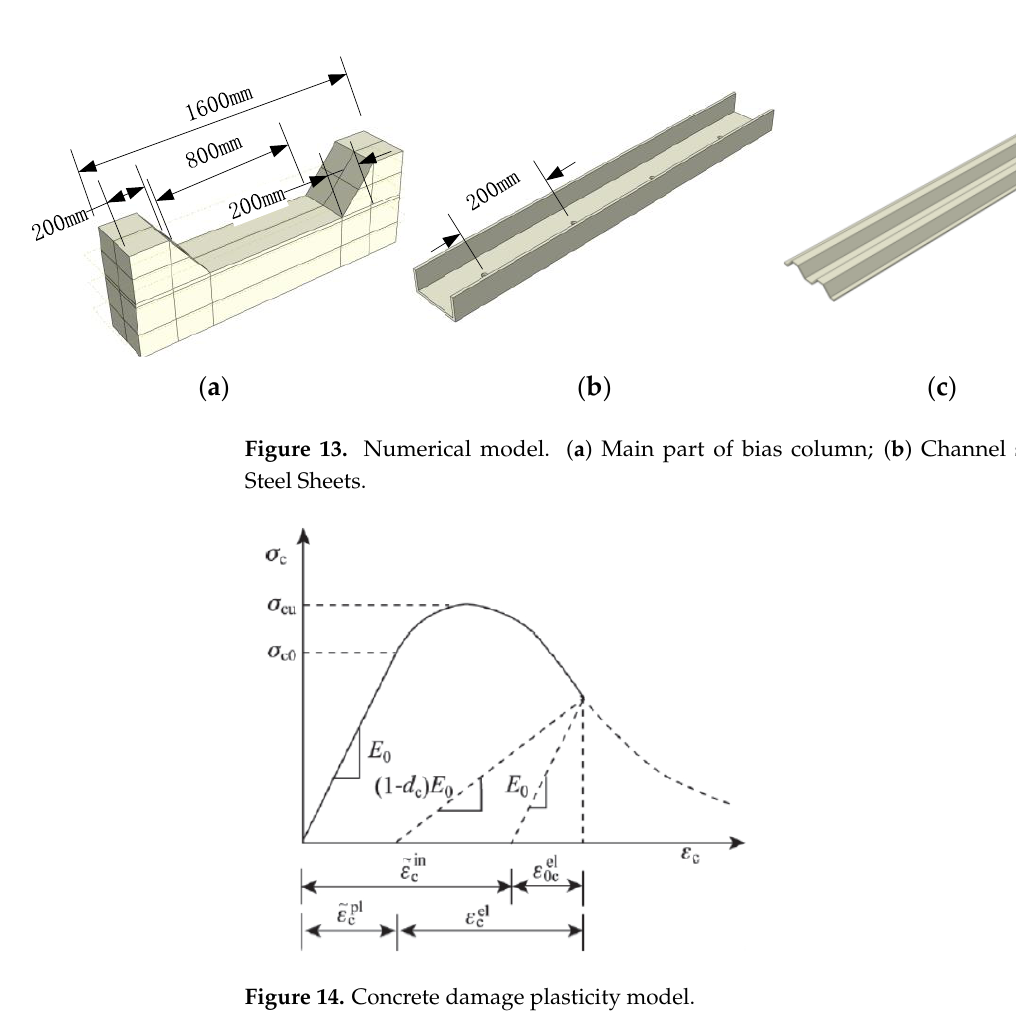
Figure 14. Concrete damage plasticity model.